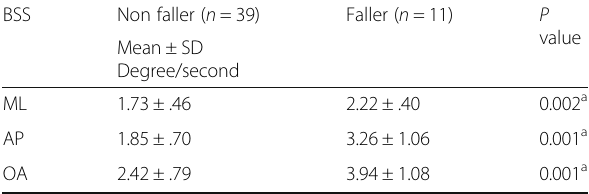
Table 4 Comparison between fallers and non-fallers as regard the degree of tilt in the limits of the stability of